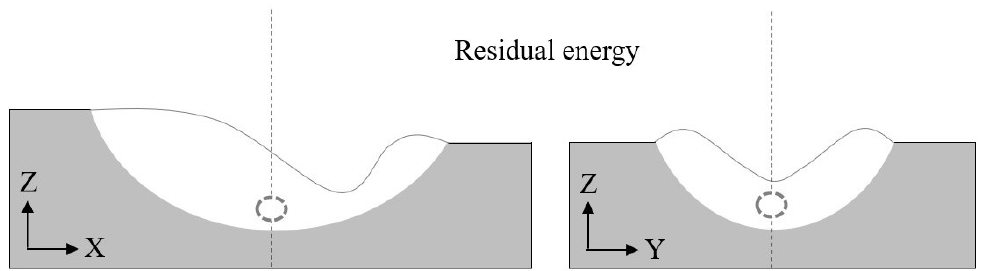
Figure 8. Residual energy transfer.